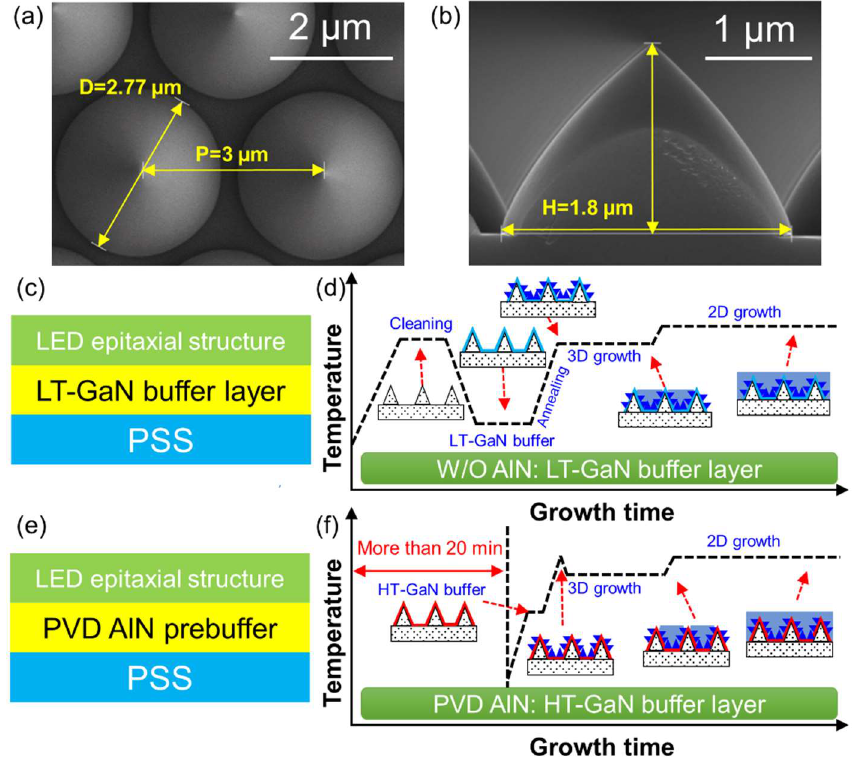
Figure 2. ( a ) Plane-view and ( b ) cross-sectional SEM images of PSS; ( c ) schematic diagram and ( d ) schematic curve of temperature transients of LED epitaxial structure with LT-GaN buffer layer; ( e ) schematic diagram and ( f ) schematic curve of temperature transients of LED epitaxial structure with PVD AlN prebuffer layer.